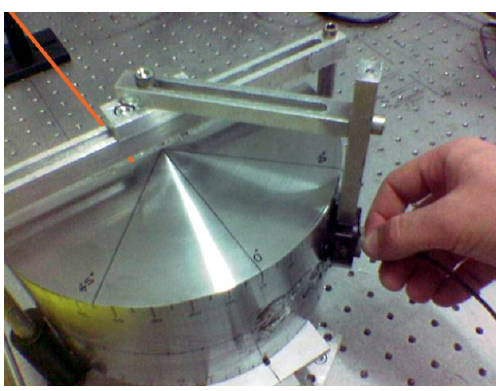
Figura 2: Disegno schematico del setup sperimentale. Figura 3: Foto del provino e del sensore per le prove a direzione di ricezione variabile. La linea arancione è tracciata per rappresentare il raggio laser.